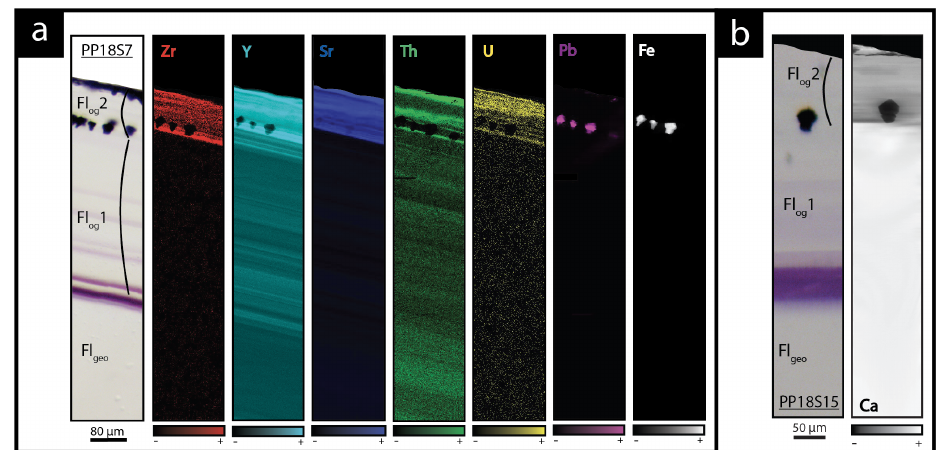
Figure 5. Transmitted plane-polarized light microphotographs and corresponding synchrotron radiation X-ray fluorescence elemental maps through a transect from the core crystal of Fl geo to the Fl og rim from (a) sample PP18S7 and (b) PP18S15. Black areas indicate a concentra- tion below the limit of detection of the element. Globular pyrite crystals are included in Fl og